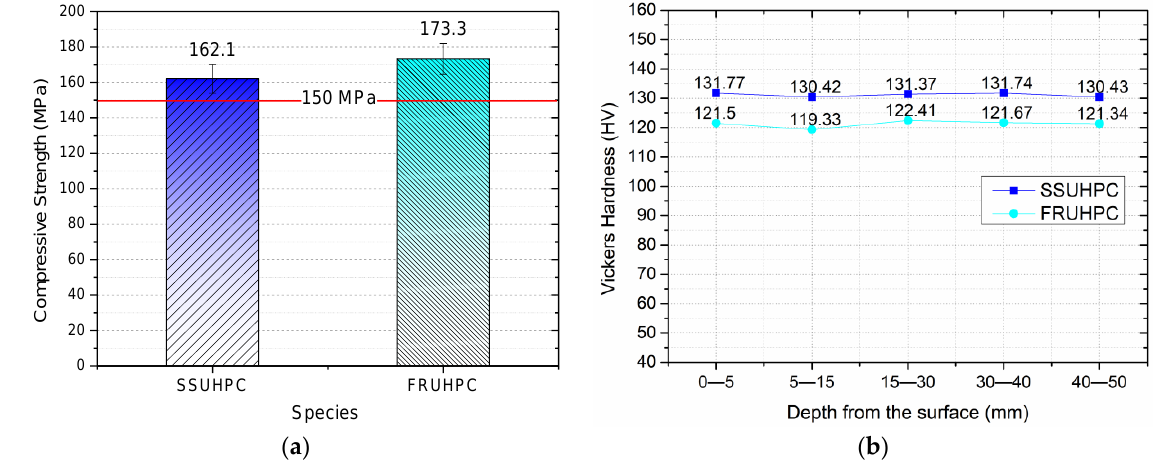
Figure 3. Comparison of compressive strength and Vickers hardness between SSUHPC and FRUHPC: ( a ) Compressive strength; ( b ) Vickers hardness.